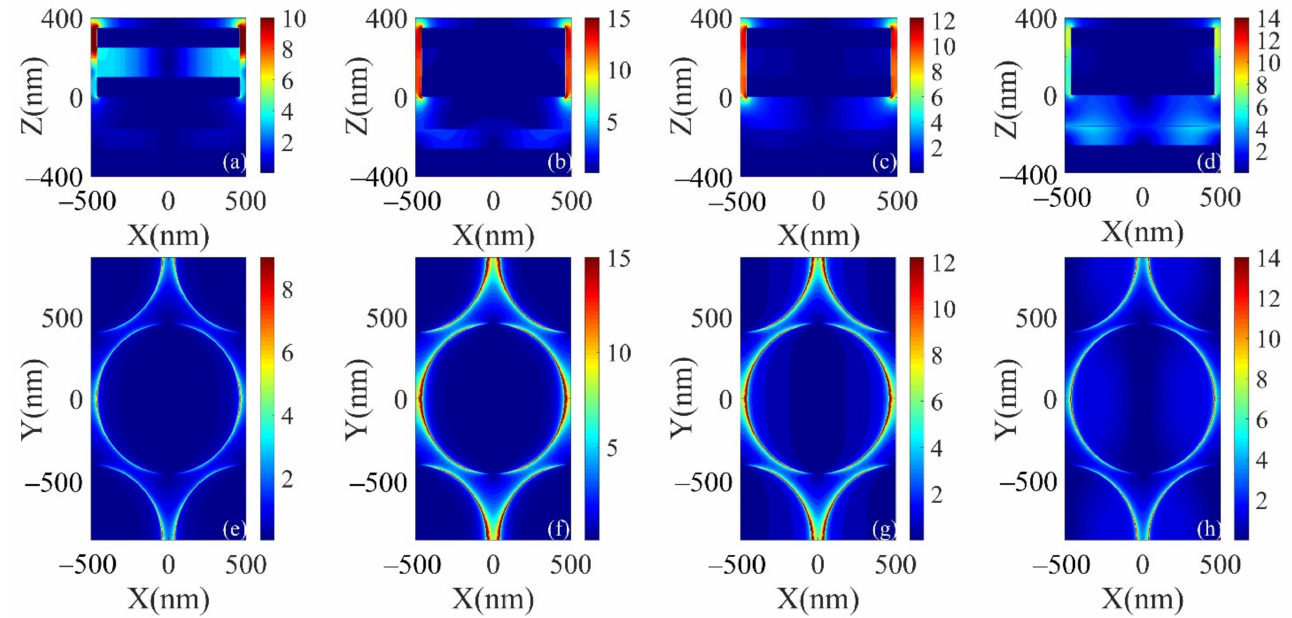
Figure 3. ( a – d ) Electric field distribution curves of resonance modes (I), (II), (III), and (IV) in the x-z plane at resonance wavelengths of 11, 15.2, 17.6, and 16.2 µ m, respectively. ( e – h ) Electric field distribution curves of resonance modes (I), (II), (III), and (IV) in the x-y plane at resonance wavelengths of 11, 15.2, 17.6, and 16.2 µ m,